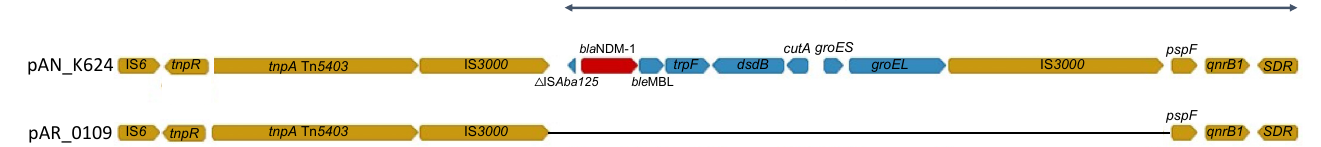
Figure 2. Genetic environment of bla NDM-1 in plasmid pAN_K624, represented using Geneious version 9.1.8. The location of the insertion of the MRR region into the pAR_0109-like plasmid backbone